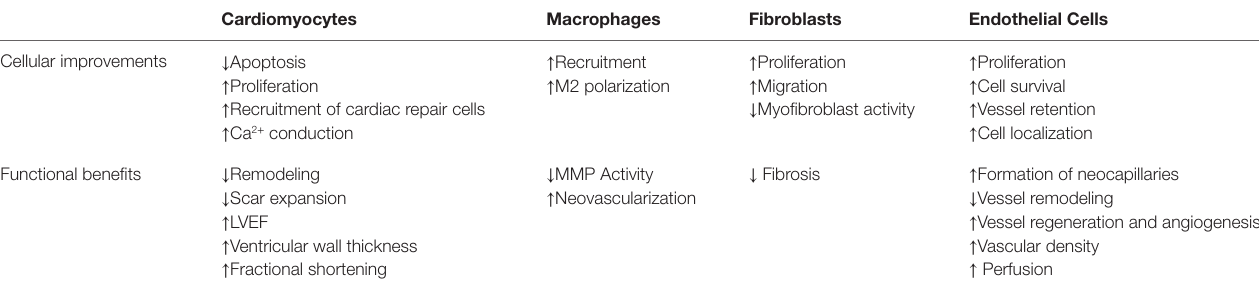
TABLe 3 | Cell responses and associated functional benefits that have been observed with different biomaterial therapy strategies.